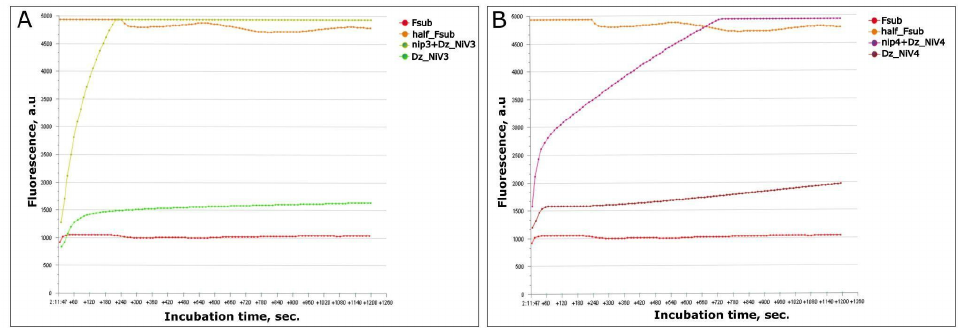
Figure 2. Feasibility analysis of Dz_NiV3 ( A ) and Dz_NiV4 ( B ). The images were directly obtained using the Axxin T16-ISO Isothermal Fluorescence Reader.